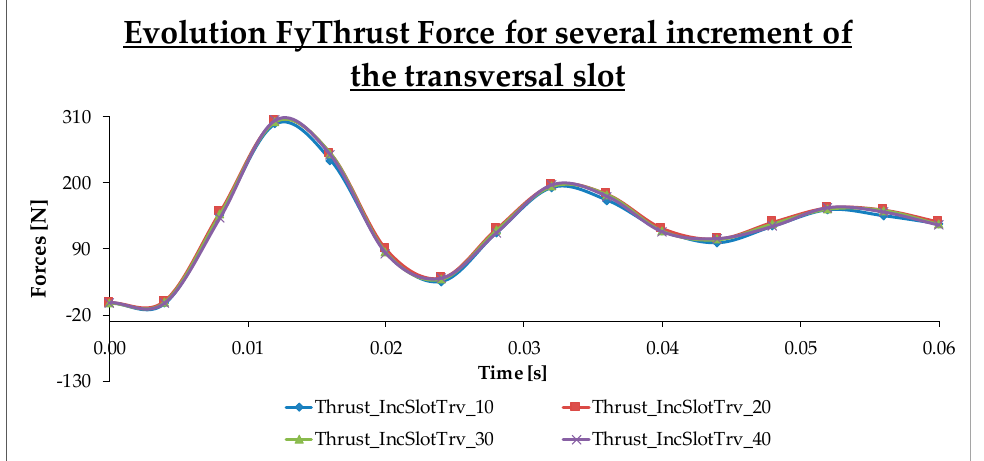
Figure 22. Thrust force in a transitory state for different values of the transversal slots.